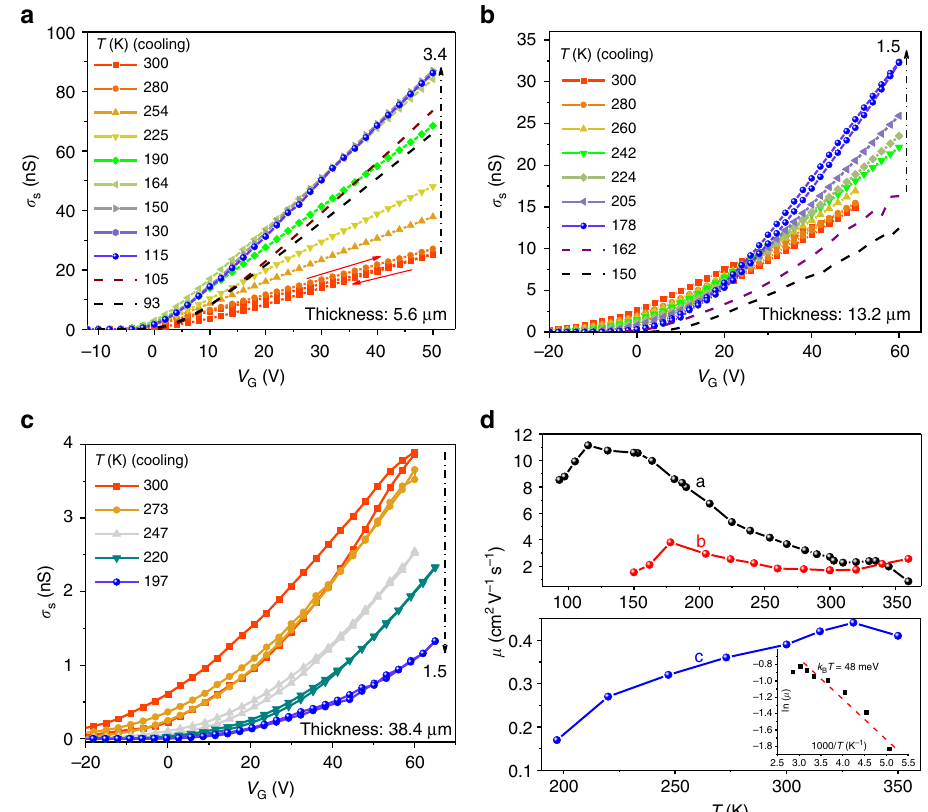
Fig. 3 Temperature-dependent FET transport as a function of Cl 2 -NDI crystal thickness. Temperature-dependent σ s - V G characteristics of a thin (5.6 μ m), b intermediate (13.2 μ m), and c thick (38.4 μ m) crystals. The curves change quantitatively and qualitatively: sheet conductance decreases, the temperature dependence inverts, V T increases, and hysteresis increases as crystals become thicker. d Extracted FET mobility vs. temperature for crystals in a – c . A clear cross-over from band-like to activated transport is observed. Inset: ln( μ ) vs. 1000/ T for the thick crystal data, where the fi tting line represents Arrhenius dependence with an activation energy of 48